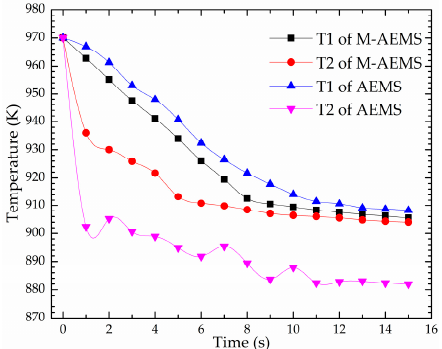
Figure 9. The numerically calculated temperature-time curves of the 7075 melt in the stirring crucible at the T 1 and T 2 points in cases of AEMS and M-AEMS.